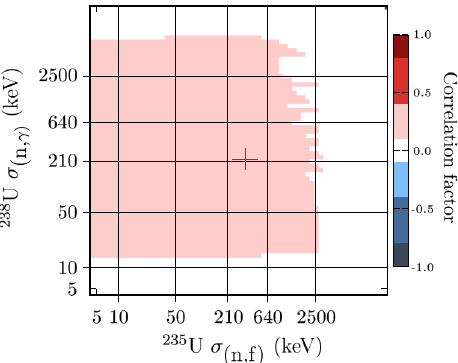
Fig. 5. As in Figure 4: correlation sub-matrix between the fi ssion and capture cross sections of 235 U. The red and black crosses indicate the average energy of the neutron causing fi ssion and capture events in the core and blanket regions, respectively.